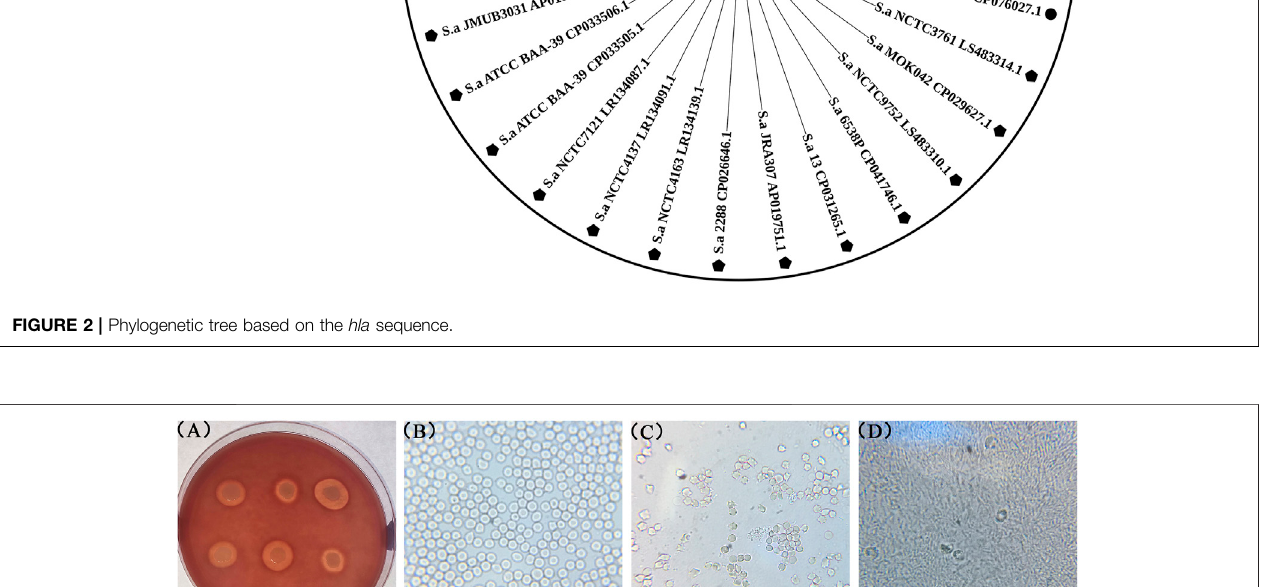
Frontiers in Pharmacology |